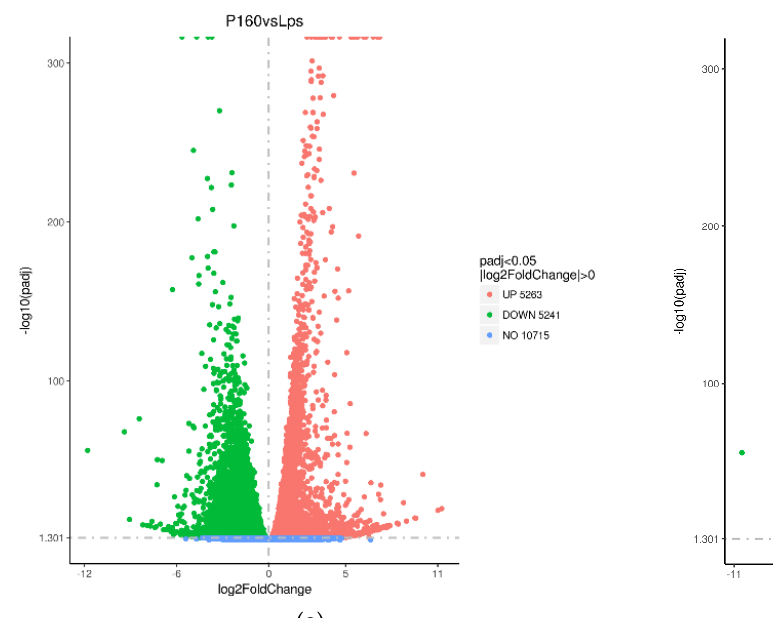
Figure 4. The differentially expressed genes volcano plots of 160/LPS ( a ) and 320/LPS ( b ). The padj is a p -value after correction for multiple hypothesis testing.